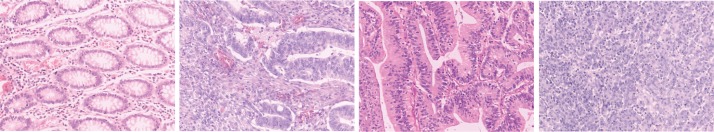
Histological image samples: From left to right, normal tissue followed by cancer of grades G1, G2 and G3.